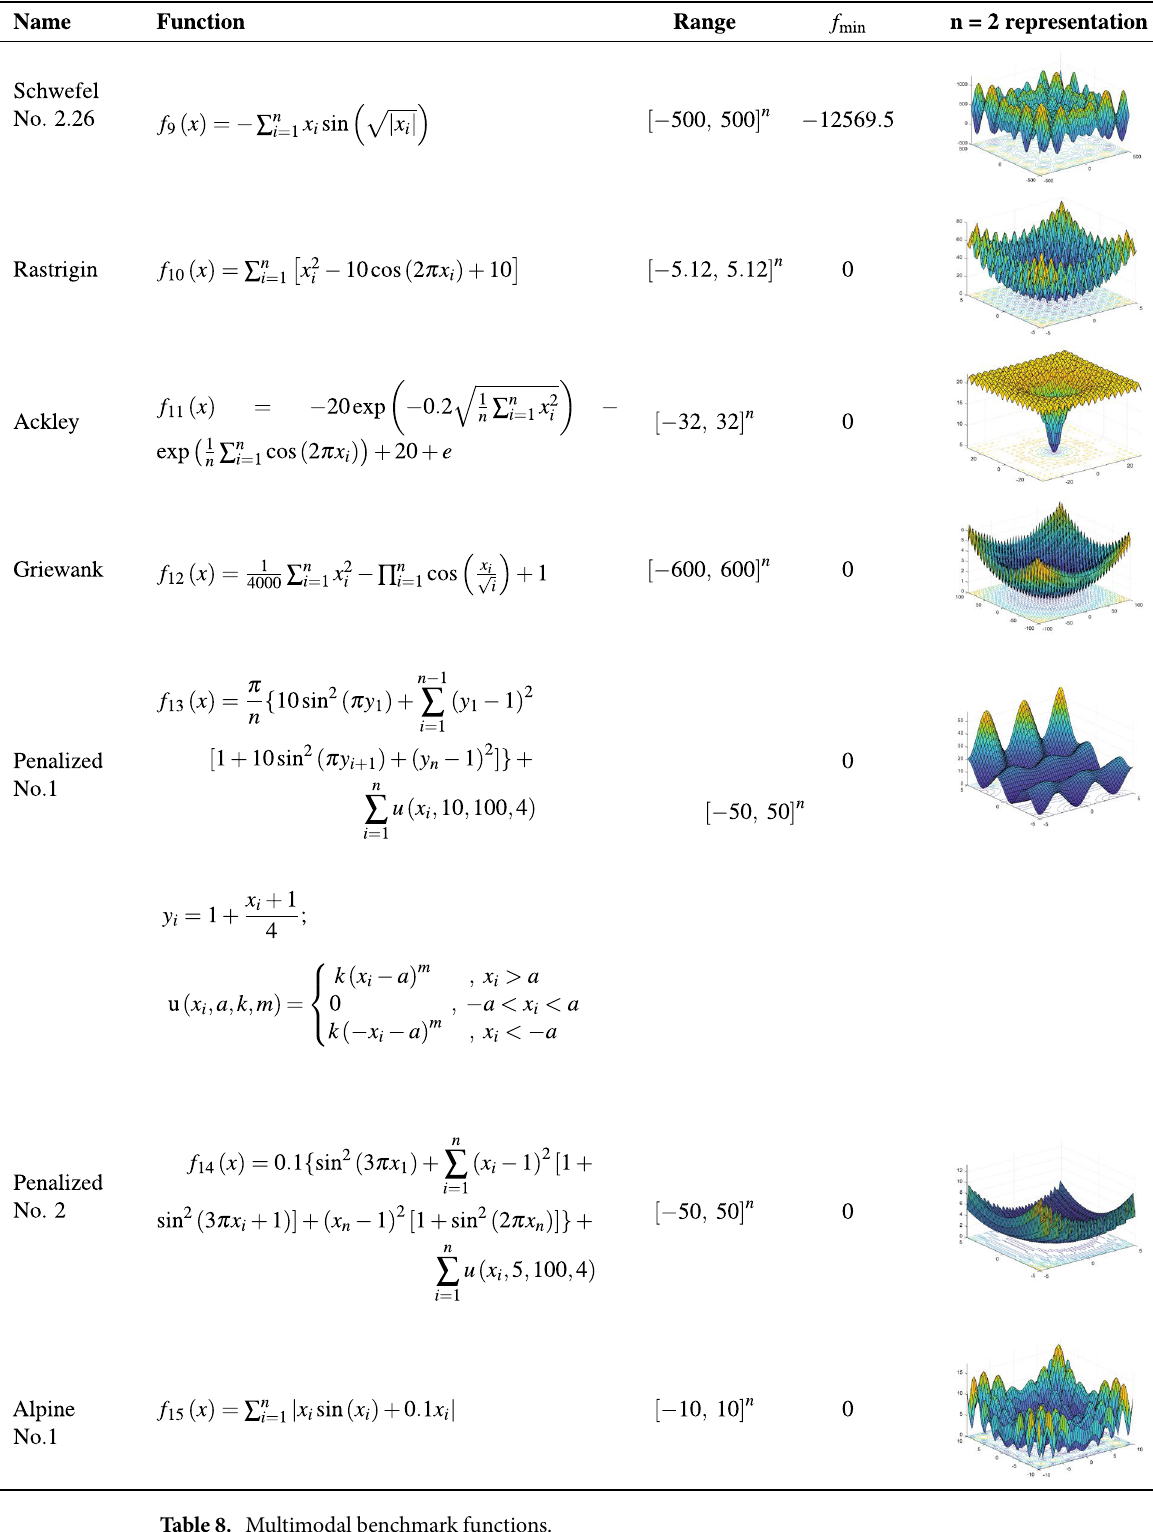
Table 8. Multimodal benchmark